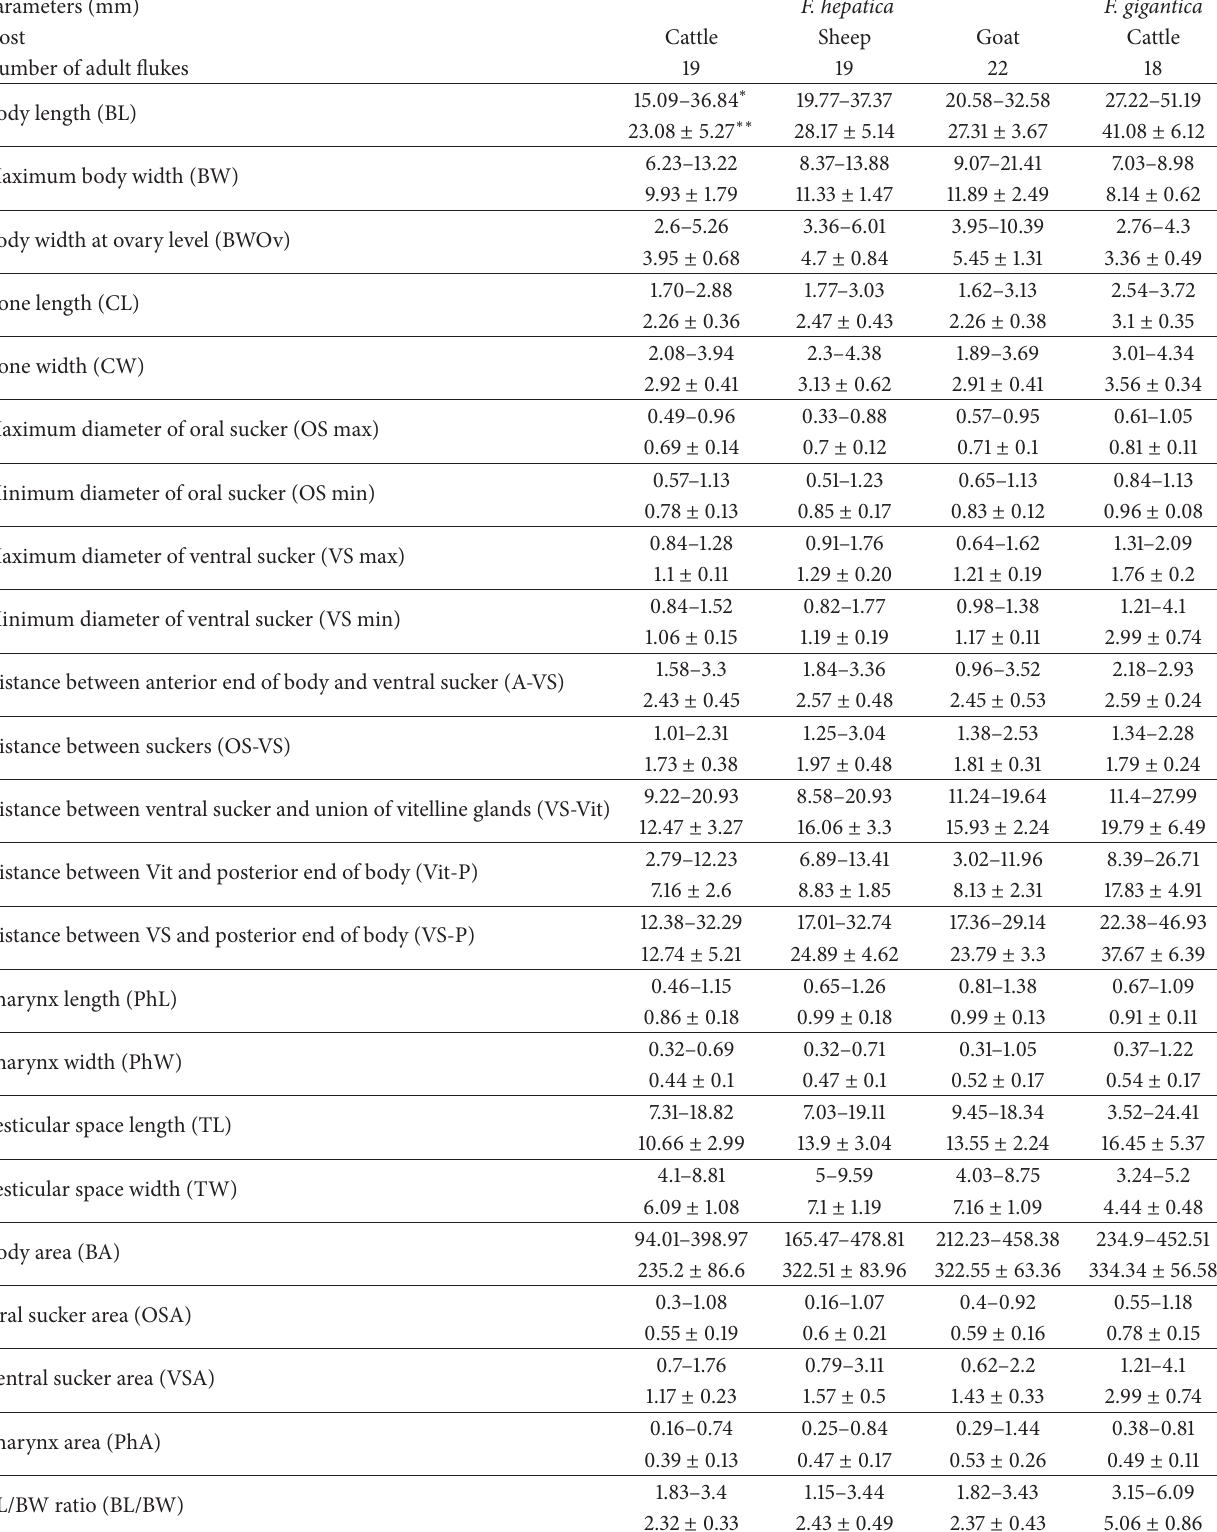
Table 2: Comparative morphometrical data on adults F. hepatica and F. gigantica from naturally infected cattle, sheep, and goat of the Kohgiluyeh and Boyer-Ahmad province, southwest of